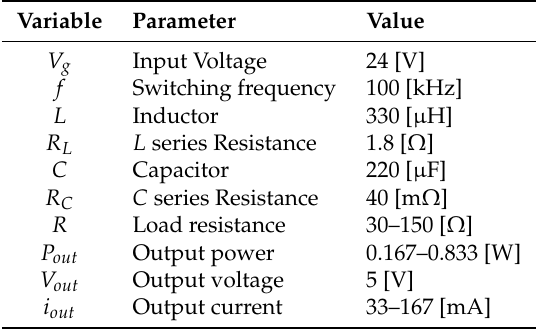
Table 2. Buck converter initial